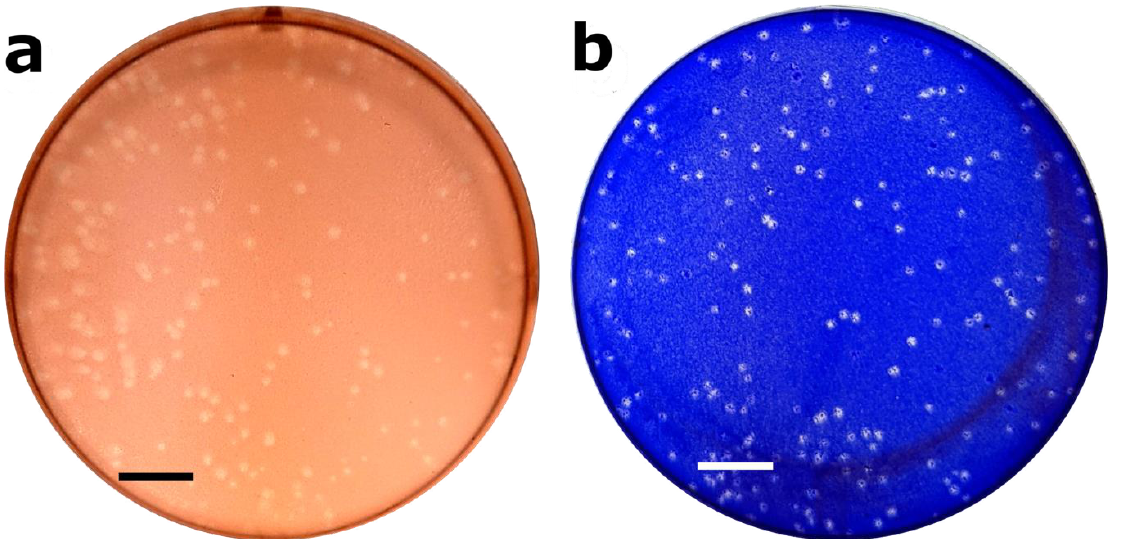
Figure 3. Example of MHV plaque assay wells in titration of two separate virus samples. ( a ) Solid agarose overlay; 4 h after staining with Neutral Red; infected with MHV (5.49 log PFU/mL) at a 10 −3 dilution. ( b ) Methyl cellulose overlay; 4 h after fixing/staining with crystal violet in formaldehyde; infected with MHV (6.59 log PFU/mL) at a 10 −4 dilution. The different dilutions of MHV shown in ( a , b ) were to present a similar countable range of plaques across the two virus samples. Scale bar represents 5 mm.